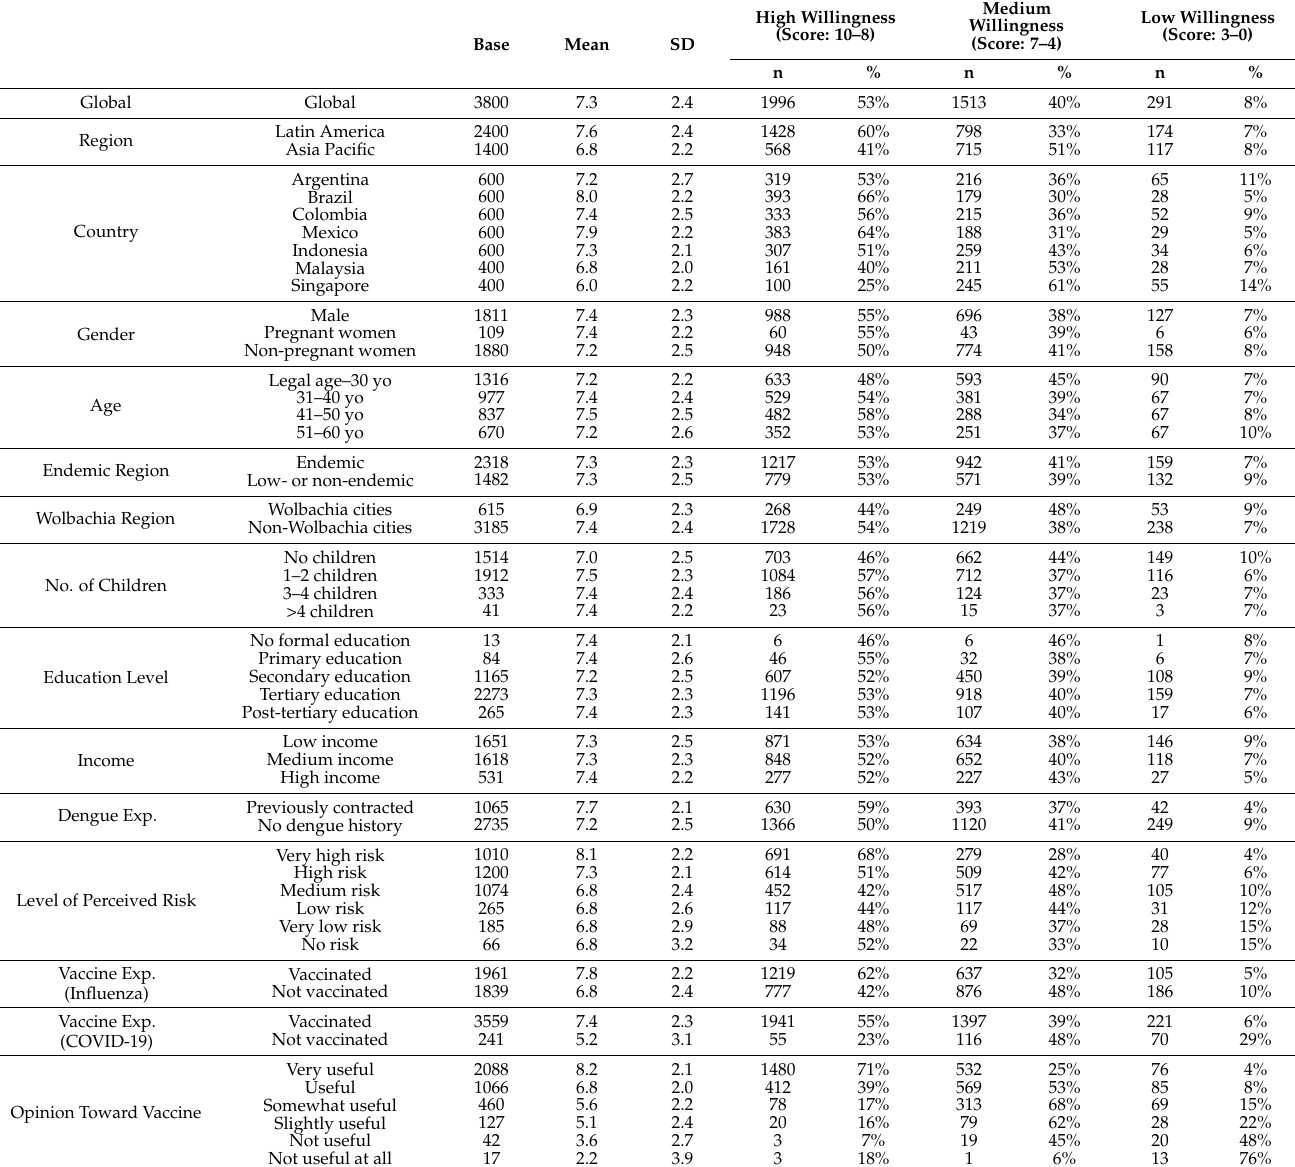
Table 2. Individual willingness to get vaccinated by a hypothetical dengue